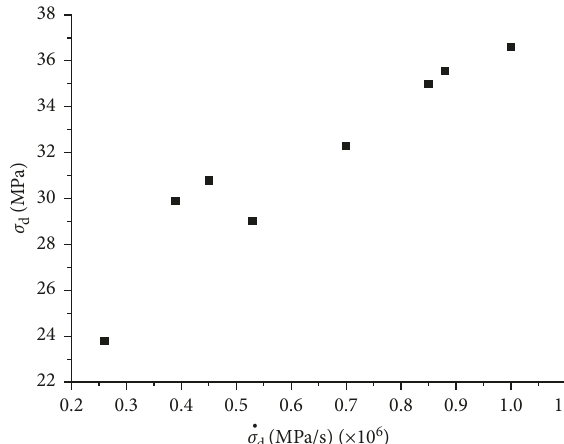
Figure 3: Typical waveform of rock specimen under dynamic tensile test.